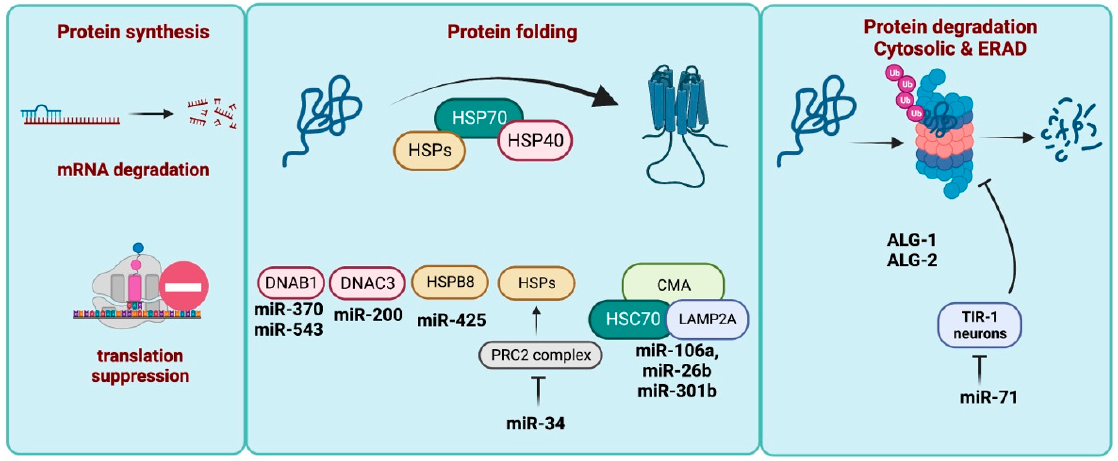
Figure 2. miRNAs regulating different components of proteostasis machinery. miRNAs regulating different components of protein folding and degradation machinery are shown. Different heat shock proteins (HSPs) including small HSPs (HSP40s or DNAJ proteins in pink) are shown along the miRNA targeting them.